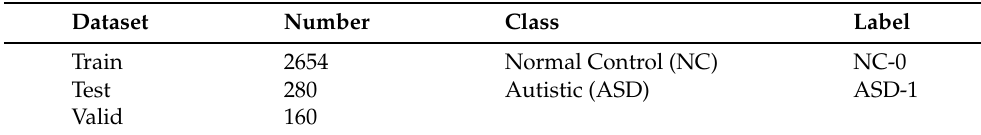
Table 9. Assignment of the second dataset used for the ablation study.